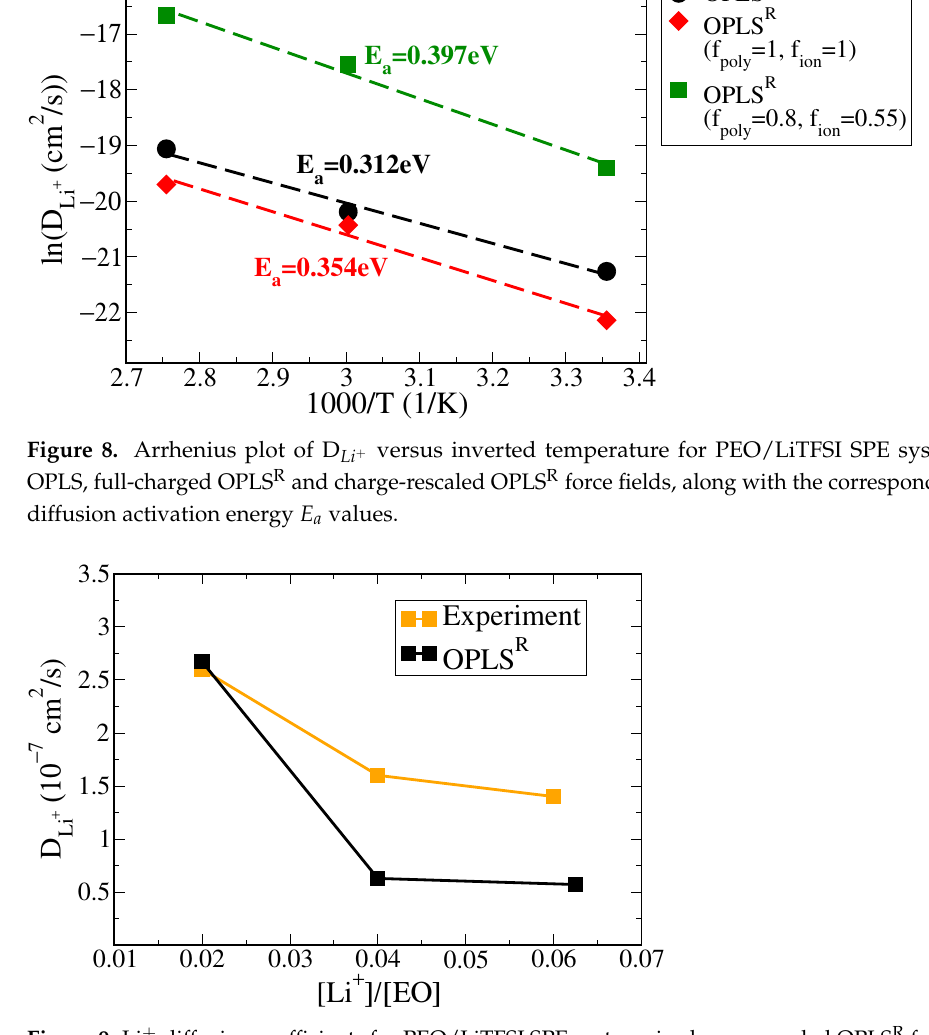
Figure 9. Li + diffusion coefficients for PEO/LiTFSI SPE systems in charge-rescaled OPLS R force field with O/Li + ratio of 50, 25 and 16, corresponding to [Li + ]/[EO] = 0.02, 0.04, and 0.0625, respectively, in comparison with experimental data from